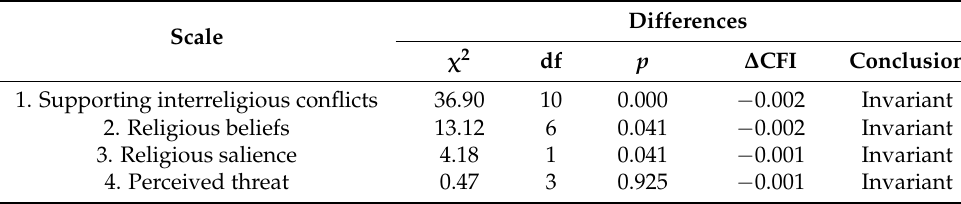
Table 3. Results of measurement invariance